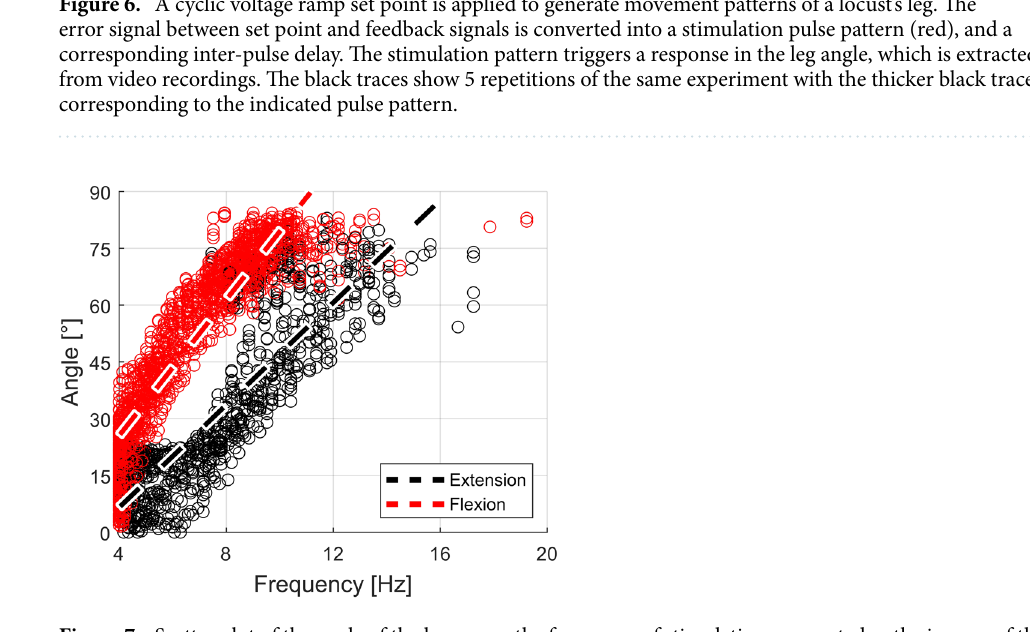
Figure 7. Scatter plot of the angle of the leg versus the frequency of stimulation, computed as the inverse of the inter-pulse delay, for the voltage ramp experiment. The upper cluster (red) represents the trajectory of flexion of the leg, whereas the lower cluster (black) represents the trajectory of extension of the leg. The linear fits are computed using the method of